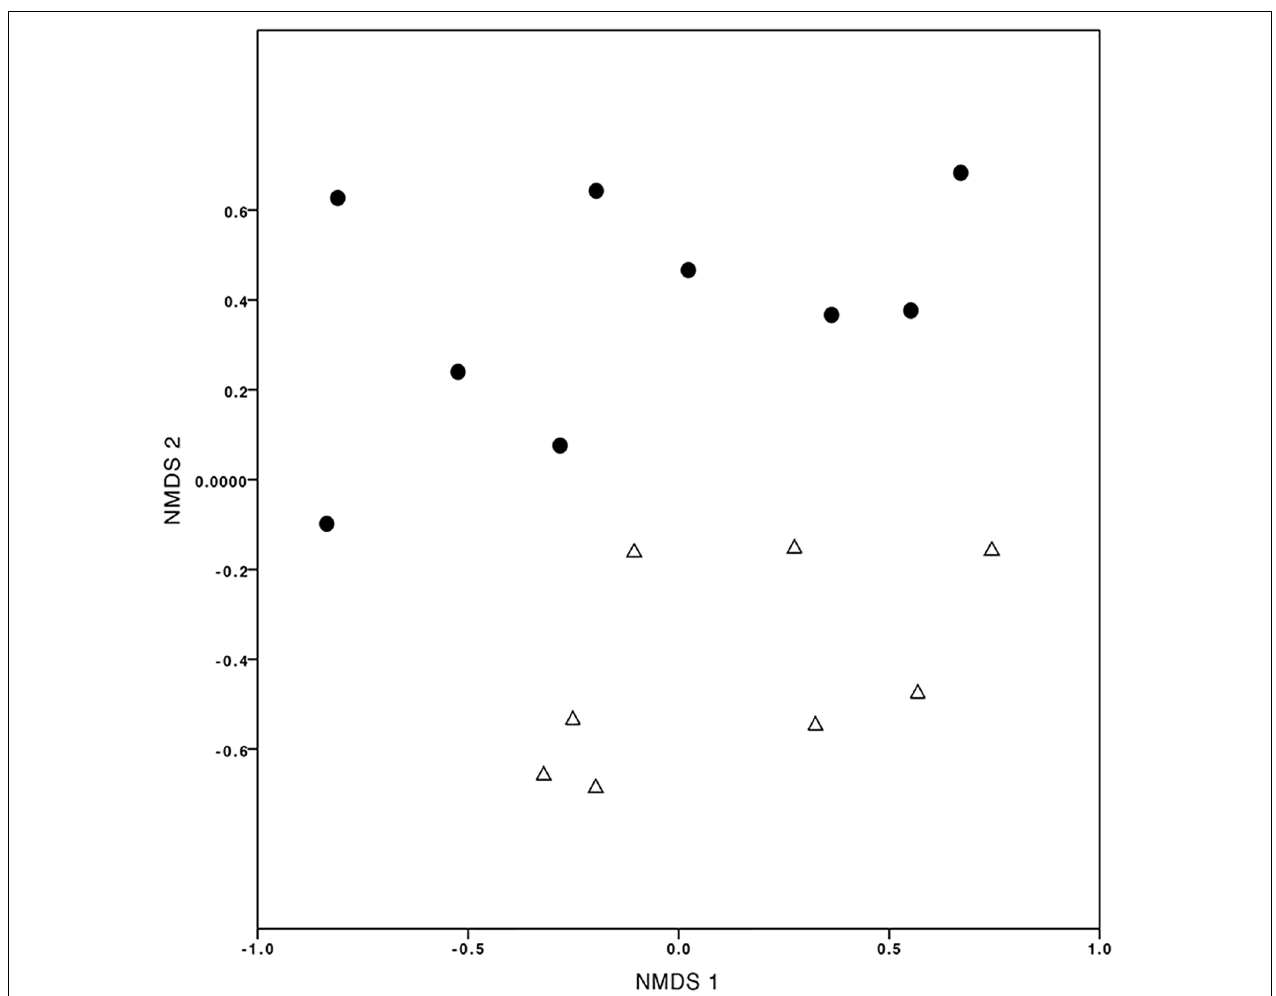
FIGURE 6 | Non-multidimensional scaling (NMDS) plot of mycorrhizal fungi detected in Cyrtochilum macrum sampled at two colonization times. The black dots correspond to samples obtained from the first sampling (T2CS1 treatment) and the white triangles correspond to the second sampling (T2CS2 treatment), after three months and one year, respectively, of the assay was established (stress value =